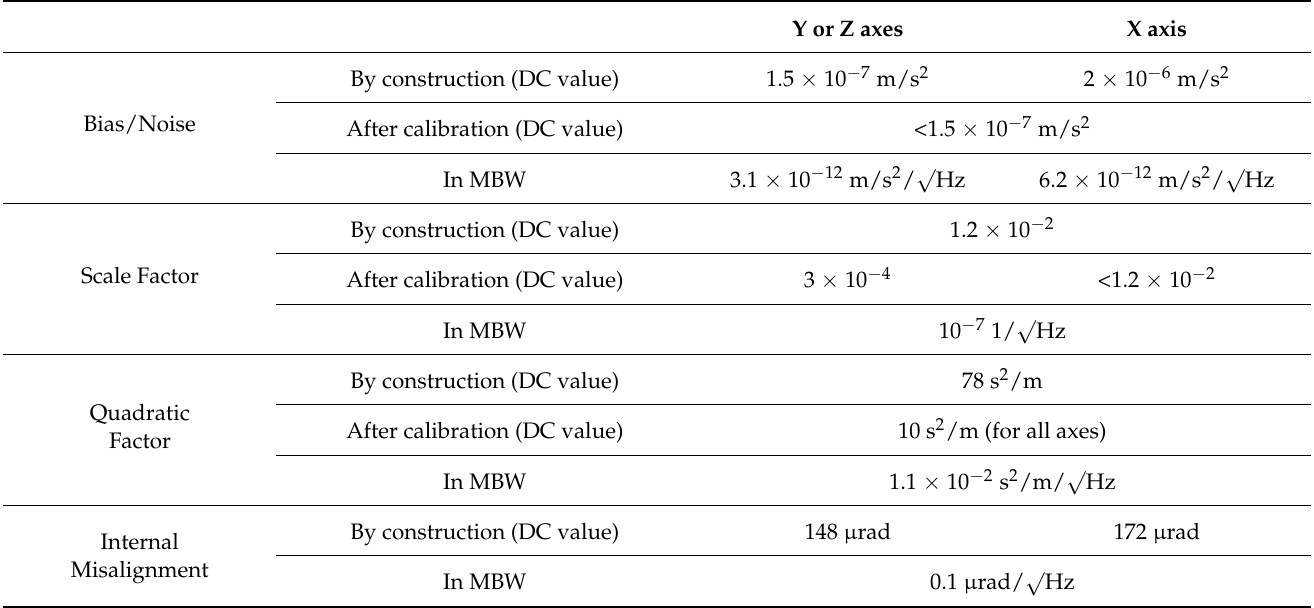
Table 3. Bias, scale factor, quadratic factor, and misalignments of the MicroSTAR accelerometer (in the accelerometer reference frame).